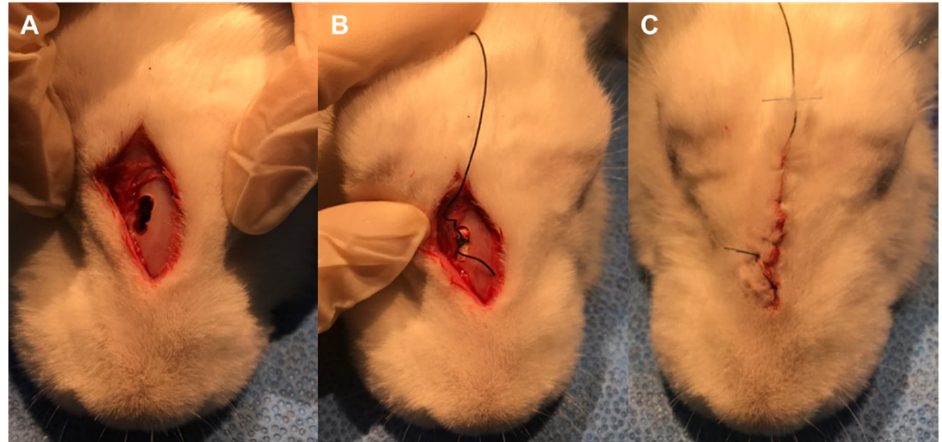
Figure 5. Induction of rhinosinusitis in a rhinogenic rabbit model. ( A ) After anesthetization, a 3 cm sized bone window was created in the anterior wall of the maxilla. ( B ) A piece of surgical sponge, Merocel (Medtronic-Xomed, Jacksonville, FL, USA), was inserted into the sino-nasal cavity to block the natural ostium of the sinuses. ( C ) The surgical window was closed using surgical thread. RS induction by inserting Merocel was performed for 2 weeks in the positive control, natural recovery, and laser-treated